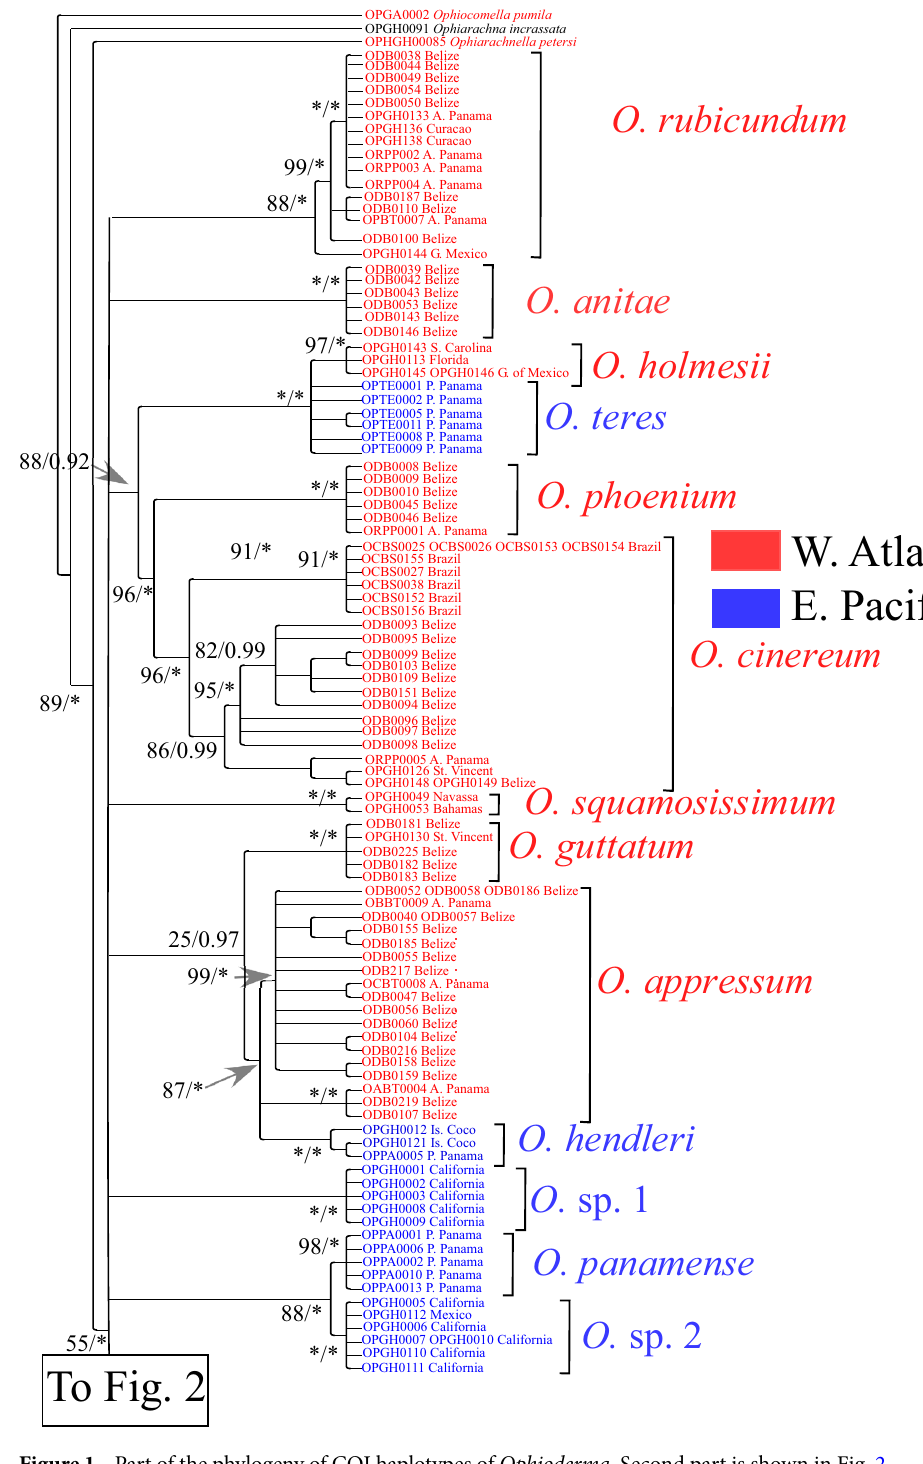
Figure 1. Part of the phylogeny of COI haplotypes of Ophioderma . Second part is shown in Fig. 2. Reconstruction is based on Maximum Likelihood (ML), using RAxML 109 , and Bayesian Information (BI) using MrBayes 108 . The tree is rooted on Ophiocomella pumila , but Ophiarachna incrassata and Ophiarachnella petersi were also included in the phylogeny to verify monophyly of Ophioderma . All nodes that did not receive support of at least 80% in ML or 0.9 in BI have been collapsed. Numbers next to nodes indicate ML and BI support (in this order). Asterisks indicate support of 100%. Codes indicate individuals in which a haplotype was